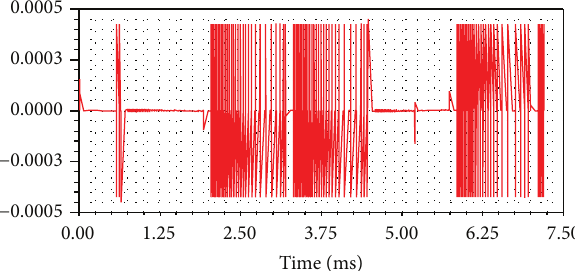
Figure 26: The leakage current in hysteresis control mode (without